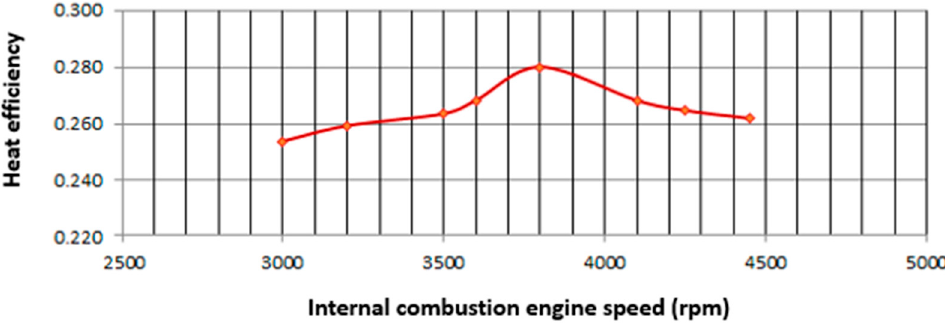
Figure 5. Heat efficiency of combustion engine when it connects with the compressor.